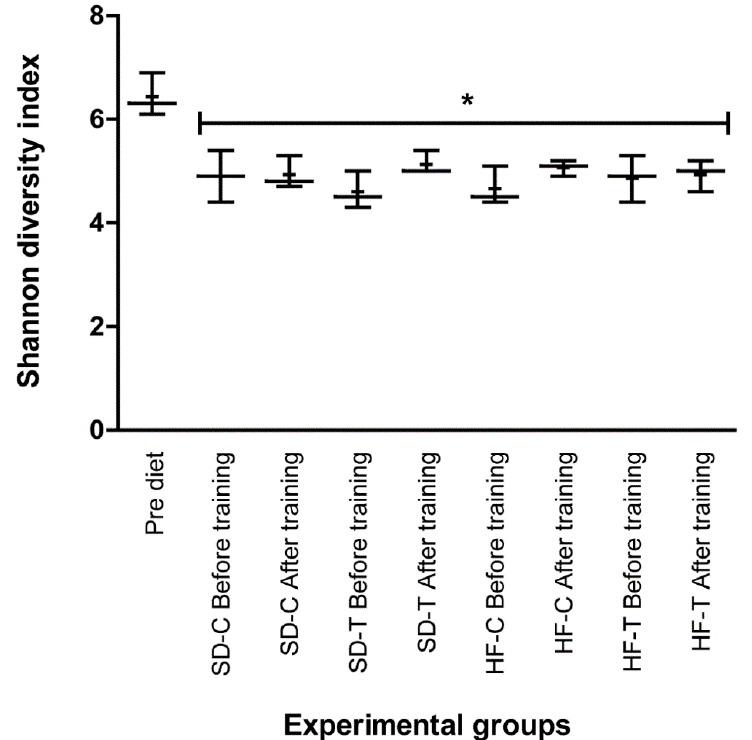
Figure 5. Bacterial alpha diversity. Comparison of alpha diversity estimation of the 16S rRNA gene libraries at 97% similarity from the sequencing analysis (ANOVA with Tukey–Kramer post-hoc test).